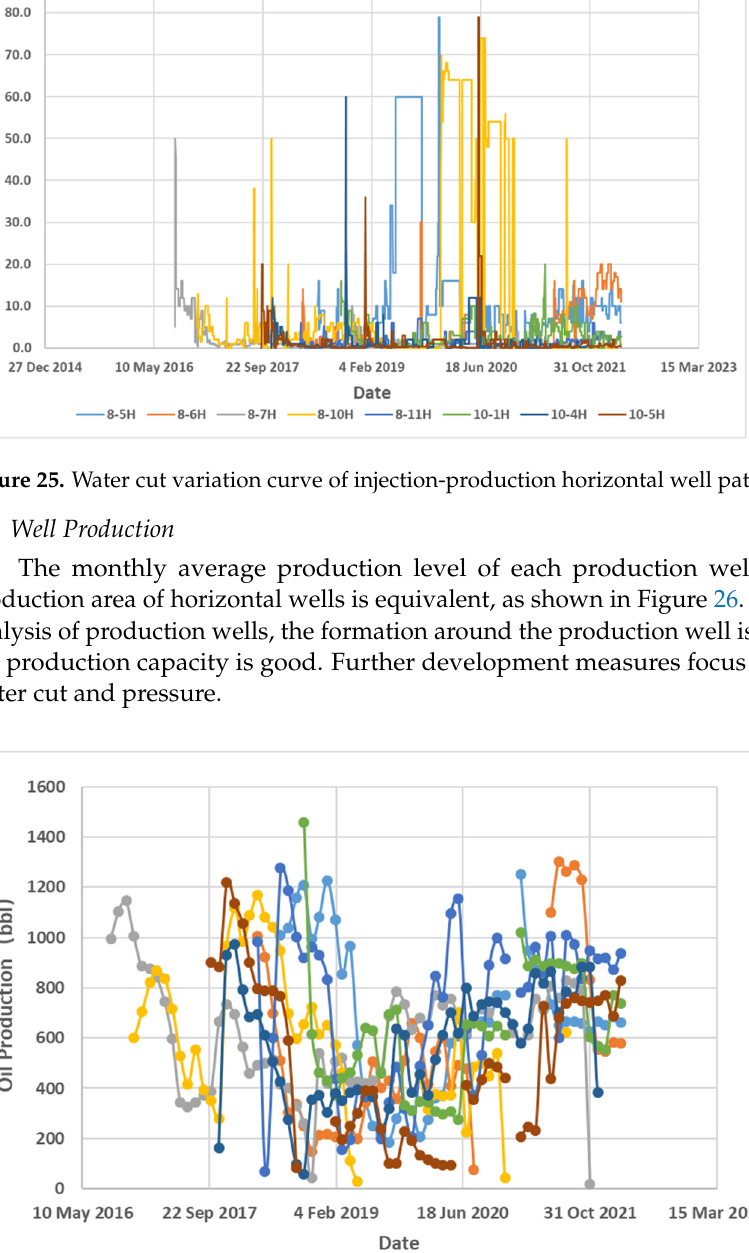
Figure 24. Streamline diagram of injection ‐ production horizontal well pattern.